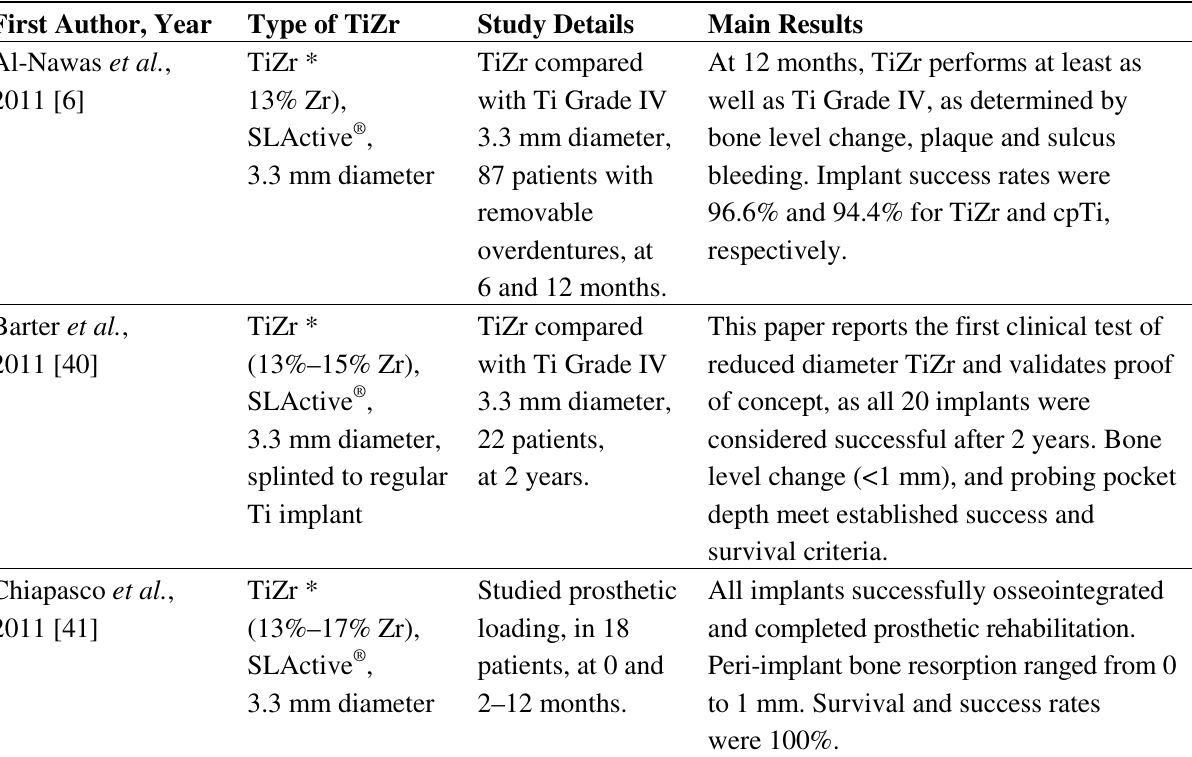
Table 3. Clinical studies of TiZr dental